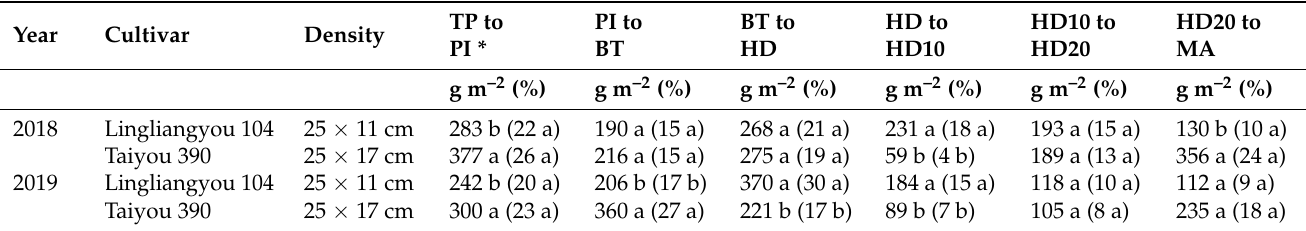
Table 4. Biomass accumulated at different growth stages of two growth-duration rice cultivars under two planting densities in 2018 and 2019.